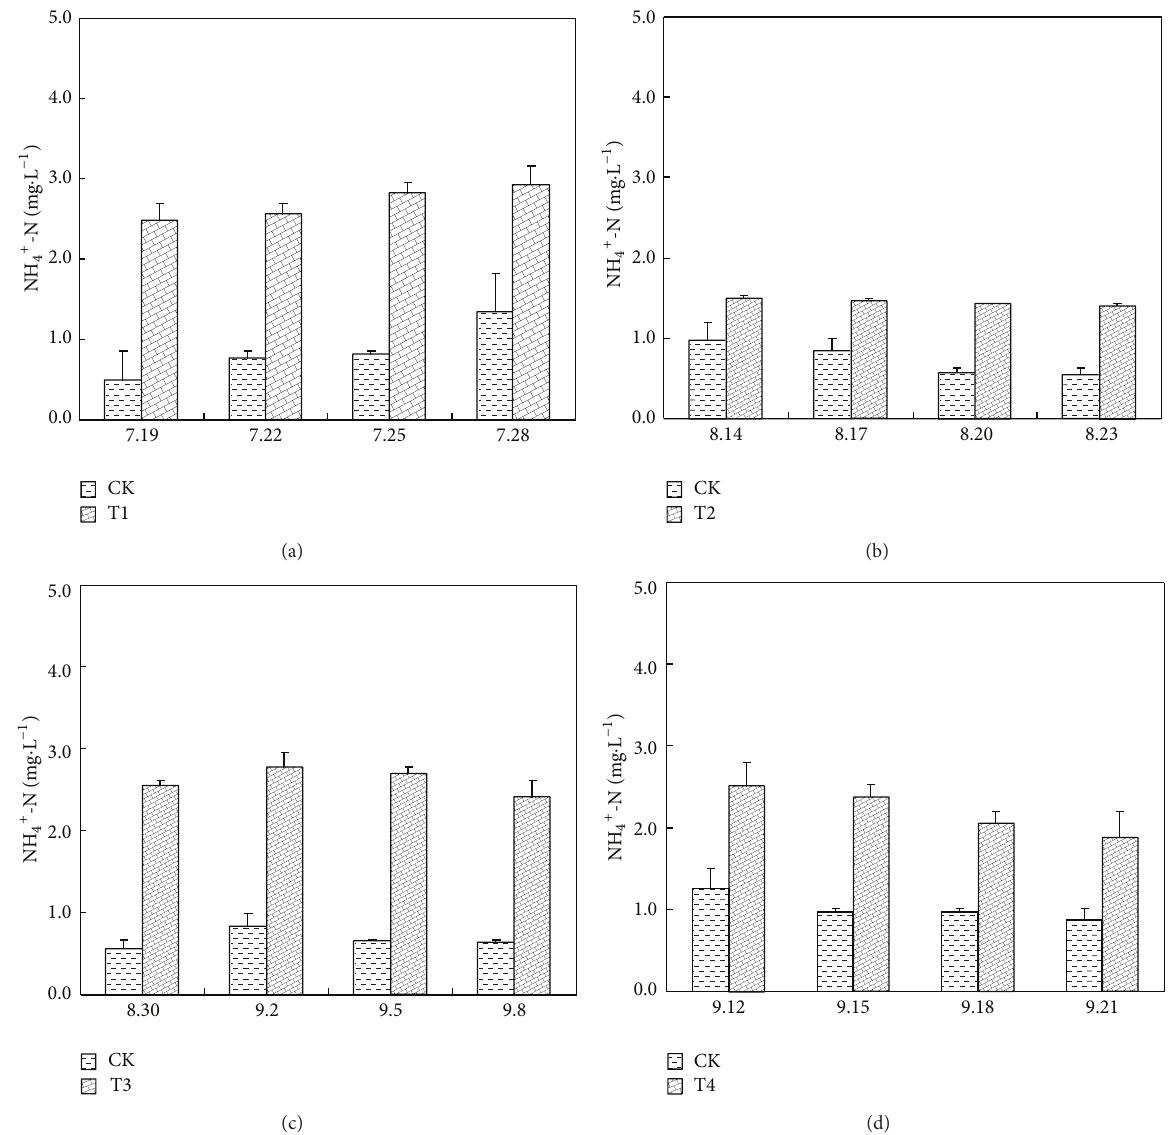
Figure 3: The change of the concentration of NH 4+ -N during submergence in 2010. CK indicates alternate drying and wet irrigation; T1, T2, T3, and T4 denote the submergence at tillering stage, jointing-booting stage, panicle initiation stage, and milky stage, respectively. Vertical bars represent ± standard error (SE) of the